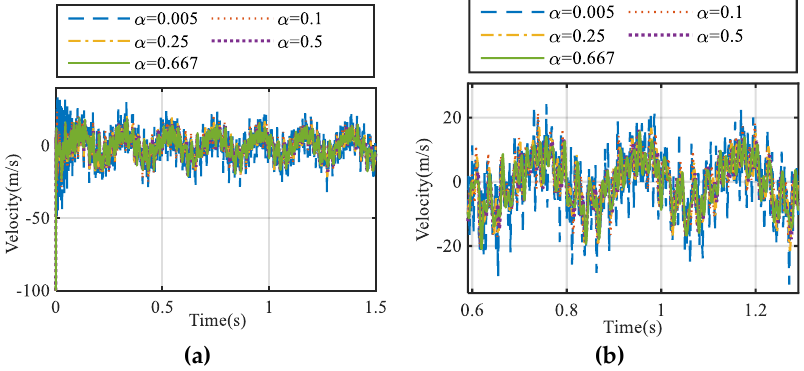
Figure 18. Velocity responses of Point A for various parameter α : ( a ) velocity responses from 0 to 1.5 s; ( b ) partial enlarged drawing of responses.